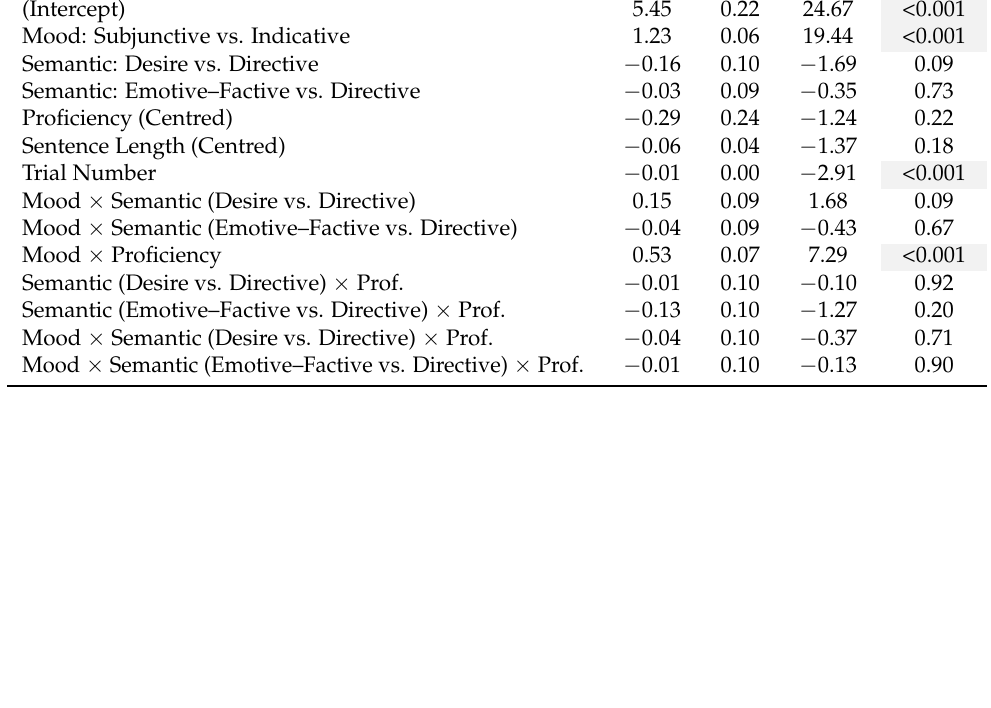
Mood: Subjunctive vs. Indicative Semantic: Desire vs. Directive Semantic: Emotive–Factive vs. Directive